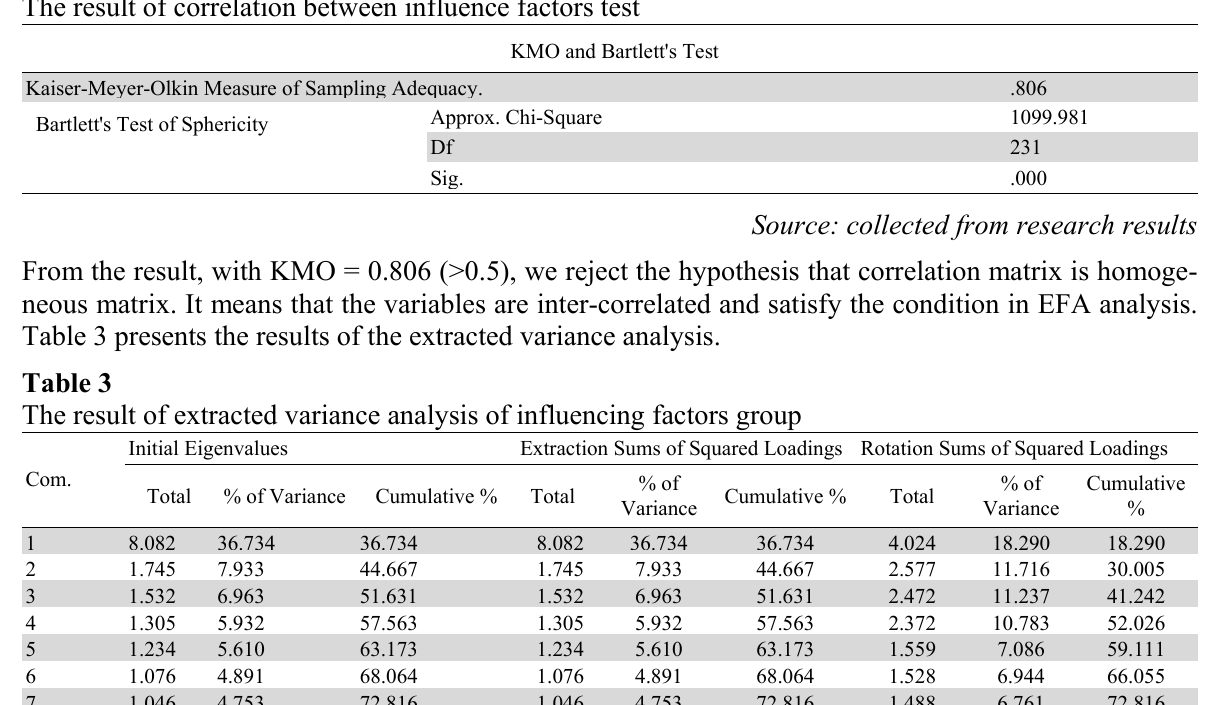
The result of correlation between influence factors test Kaiser-Meyer-Olkin Measure of Sampling Adequacy.